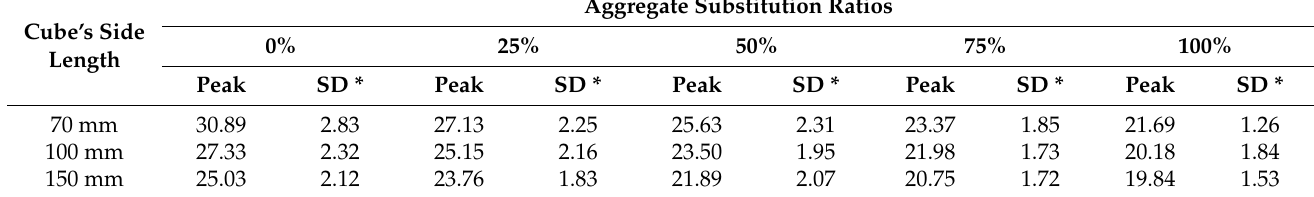
Aggregate Substitution